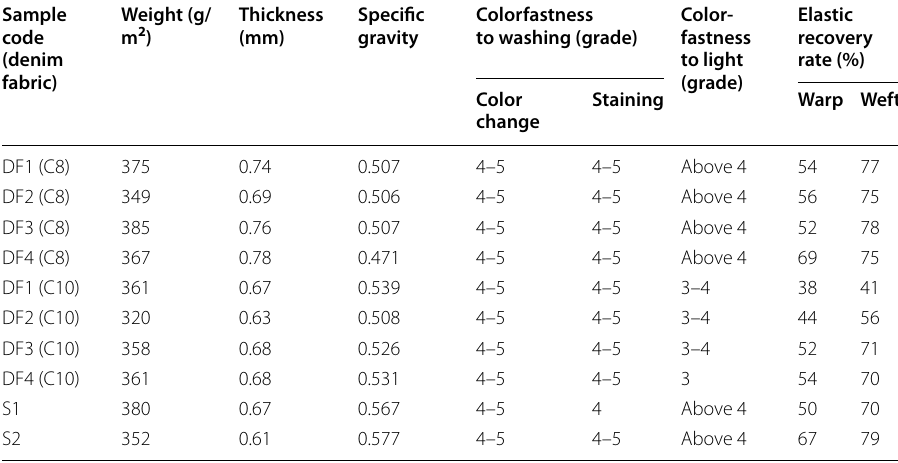
Table 2 Specific gravity, colorfastness, and elastic recovery rate of Hanji denim fabrics Sample